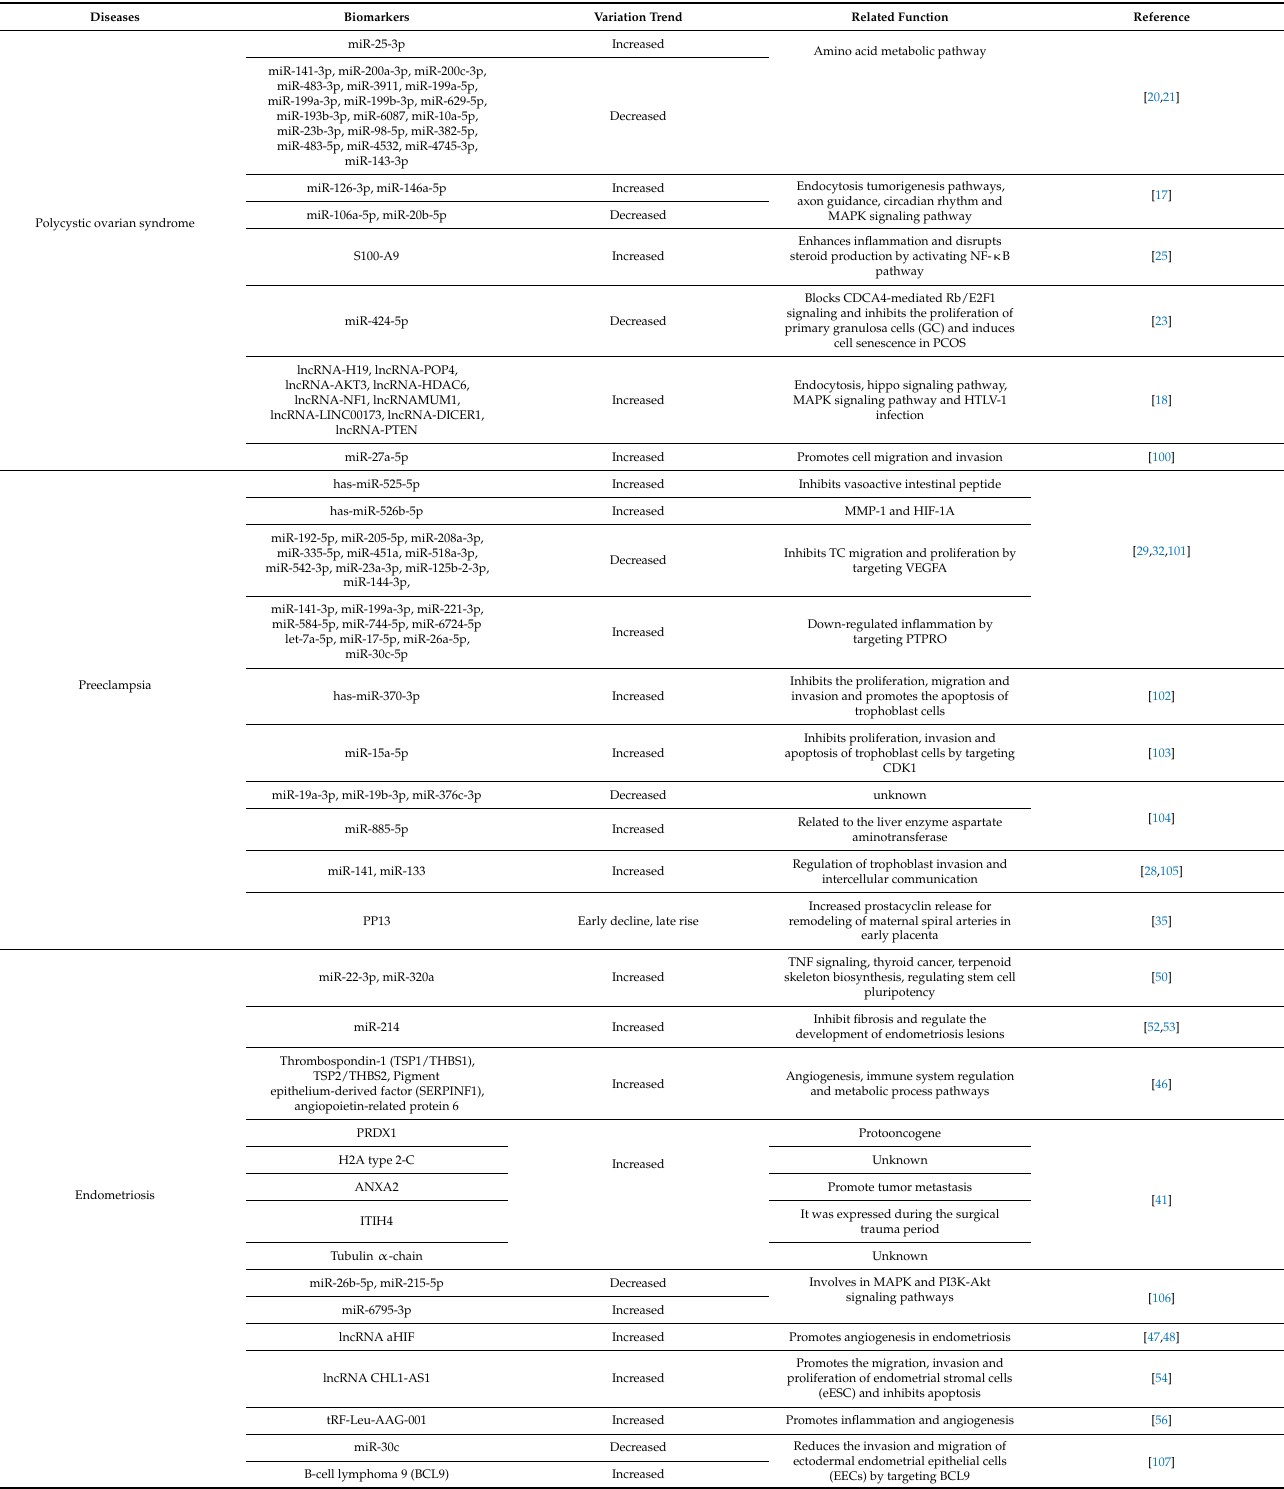
Table 1. Exosomal markers for the diagnosis of reproductive diseases and their related